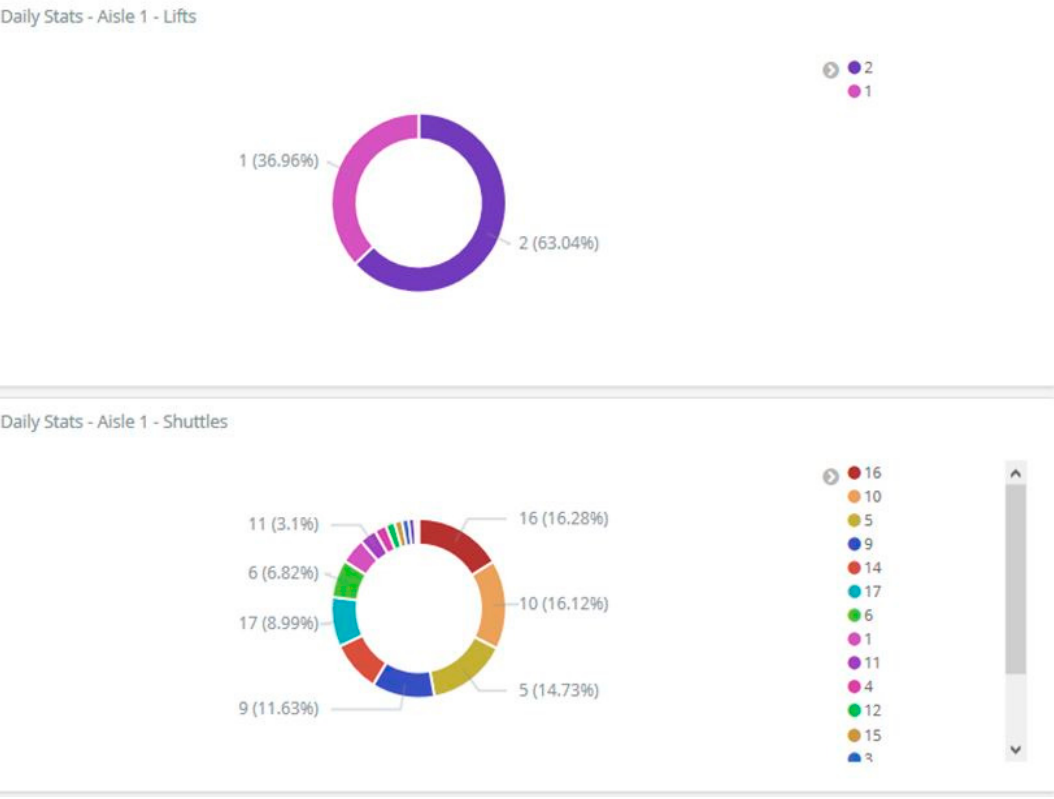
Figure 10. Visualization of system error messages.